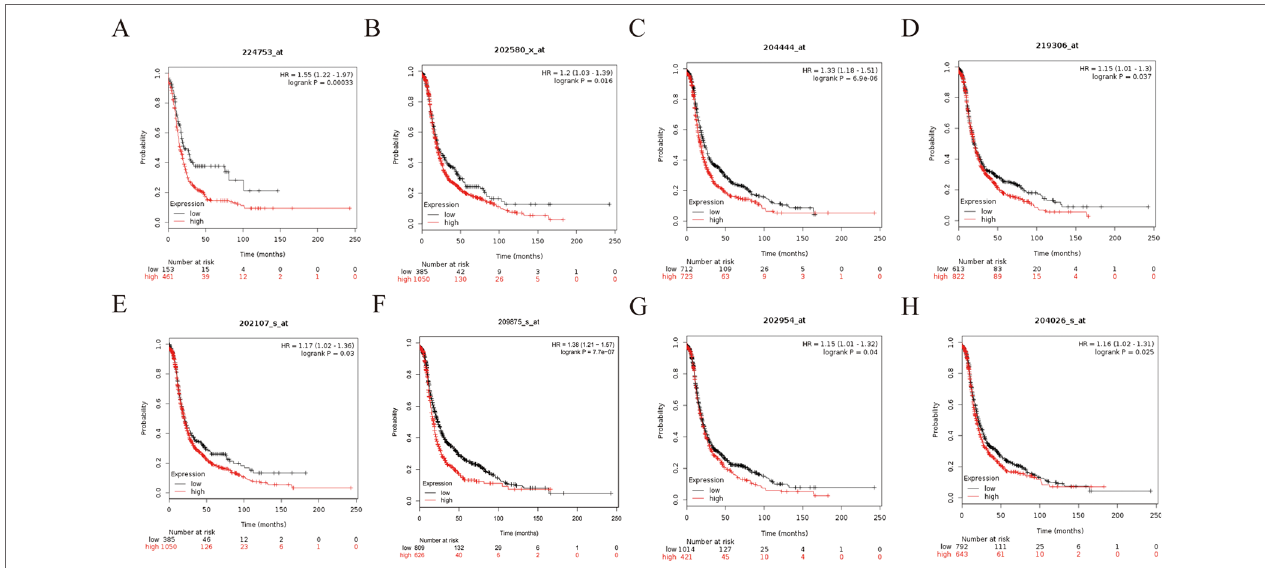
FIgUrE 10 | Progression-free survival ( PFS ) survival curves of eight hub genes. (A) CDCA5, (B) FOXM1, (C) KIF11, (D) KIF15, (E) MCM2, (F) SPP1, (g) UBE2C, (h) ZWINT.